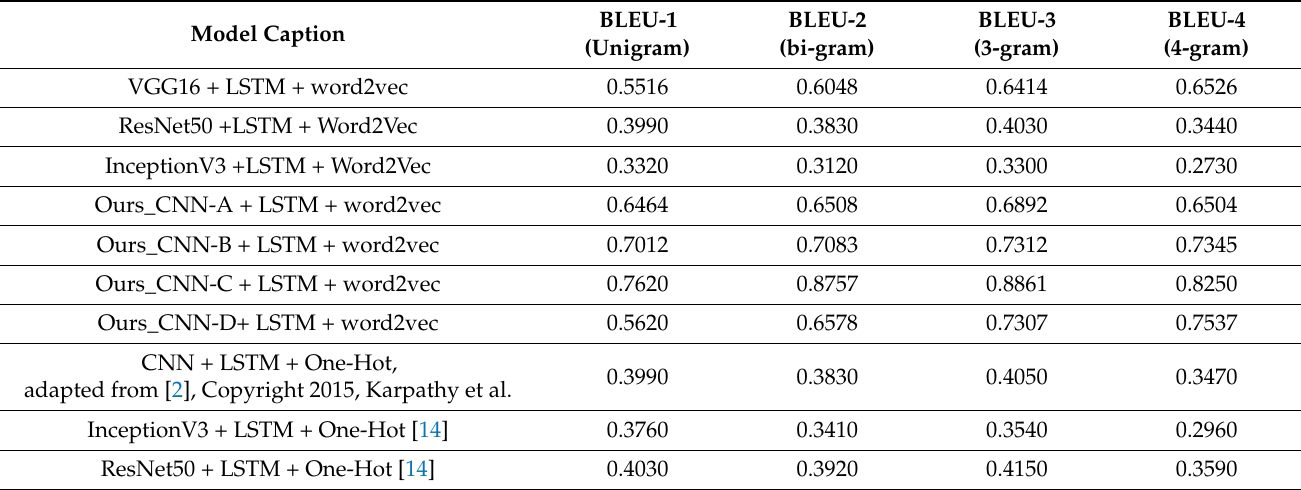
Table 2. Comparison of BLEU-N scores. Results gained from experiments using the testing dataset and executed using the baseline and proposed